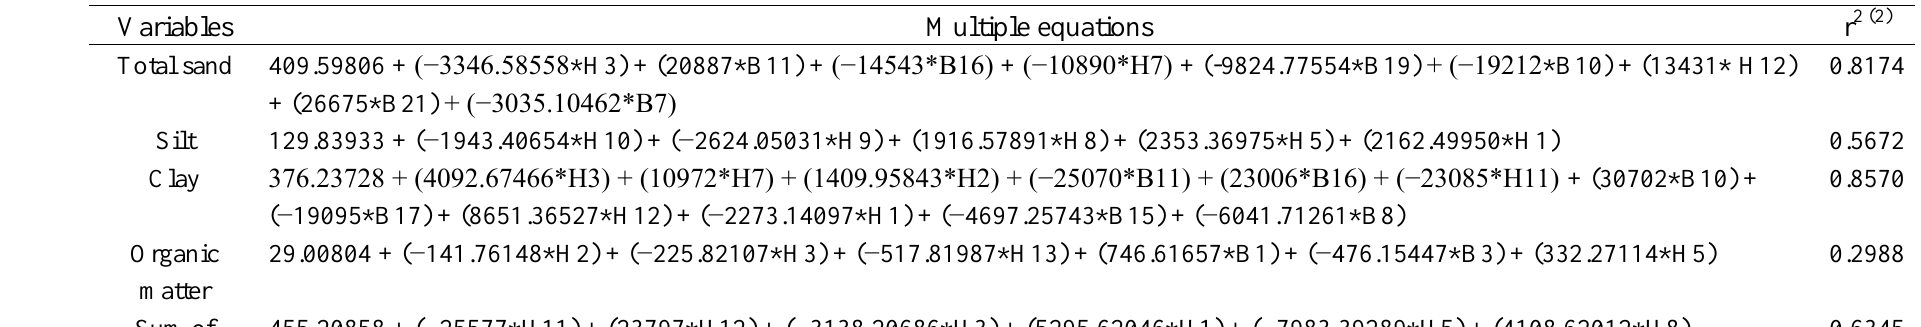
Table 1. Multiple regression equations to estimate soil attributes by laboratory sensor using 22 bands and 13 heights (using 474 observations).